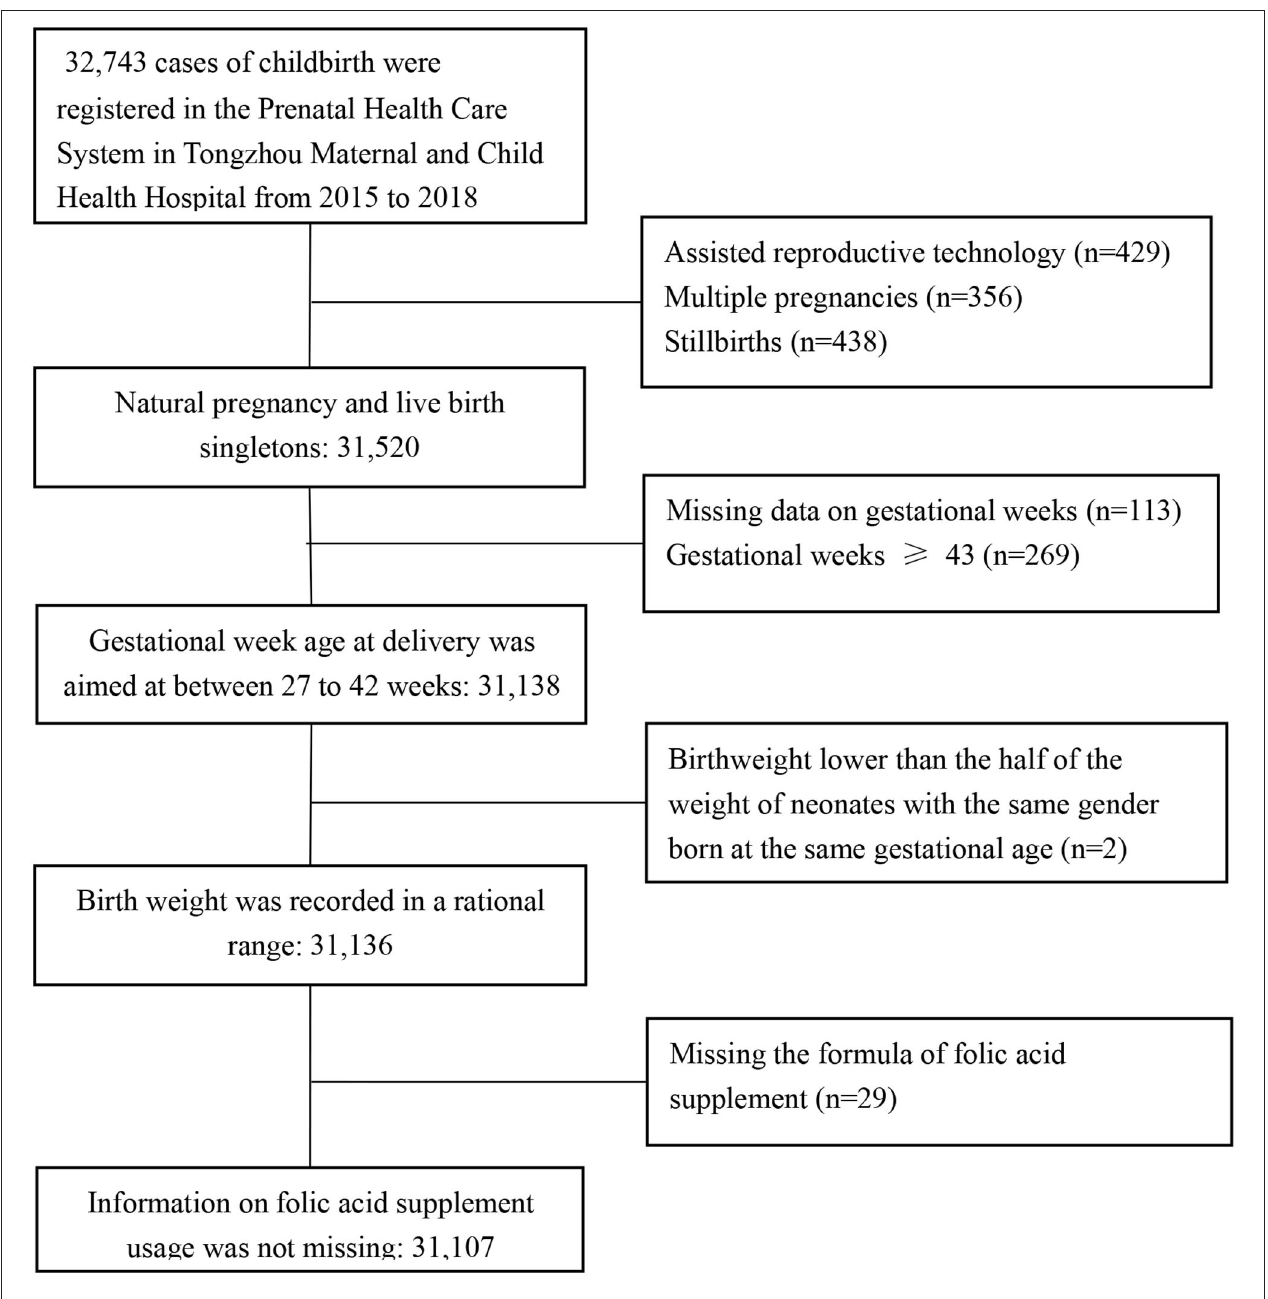
FIGURE 1 | Chart for the selection of